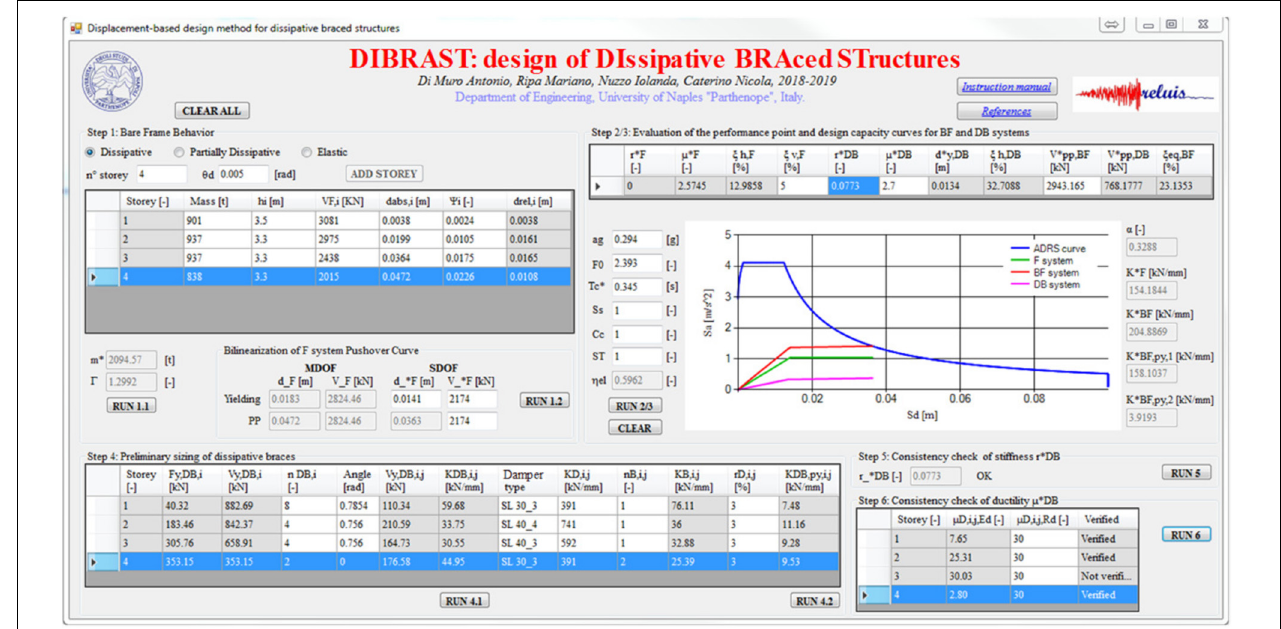
FIGURE 11 | Damping braces design by means of DIBRAST.